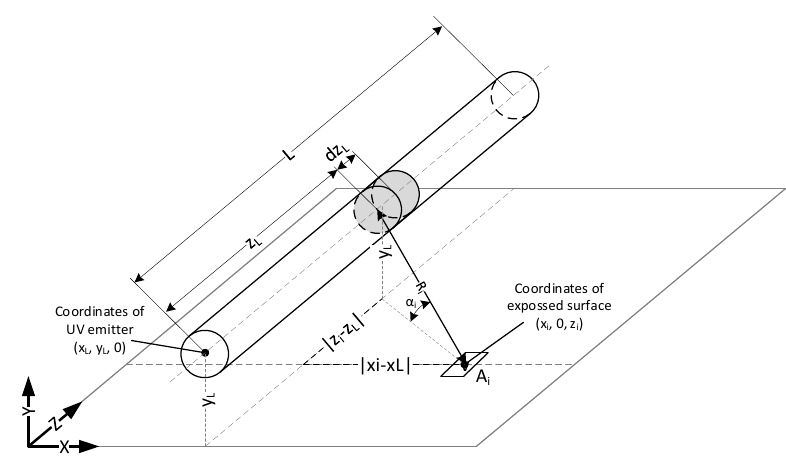
Figure 5. A fragment of the radiator illuminating a fragment of the sterilized surface.